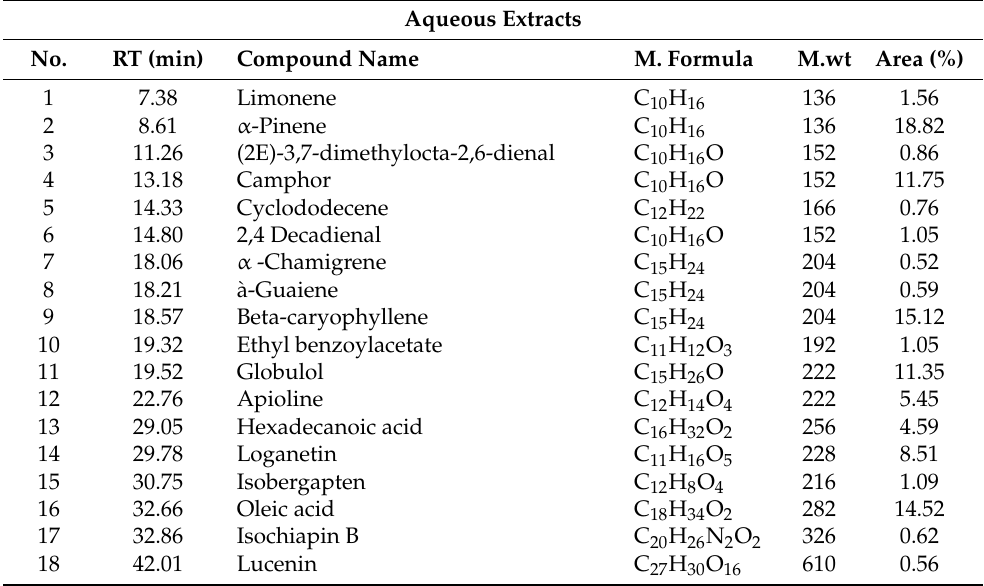
Table 3. GC-MS for bioactive chemical components of different extracts from S. aromaticum *.